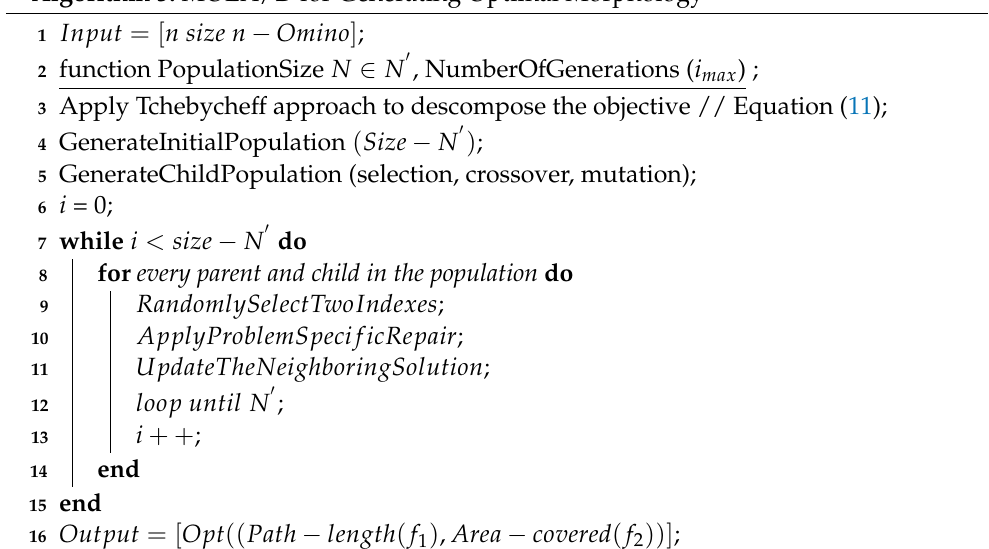
Algorithm 3: MOEA/D for Generating Optimal